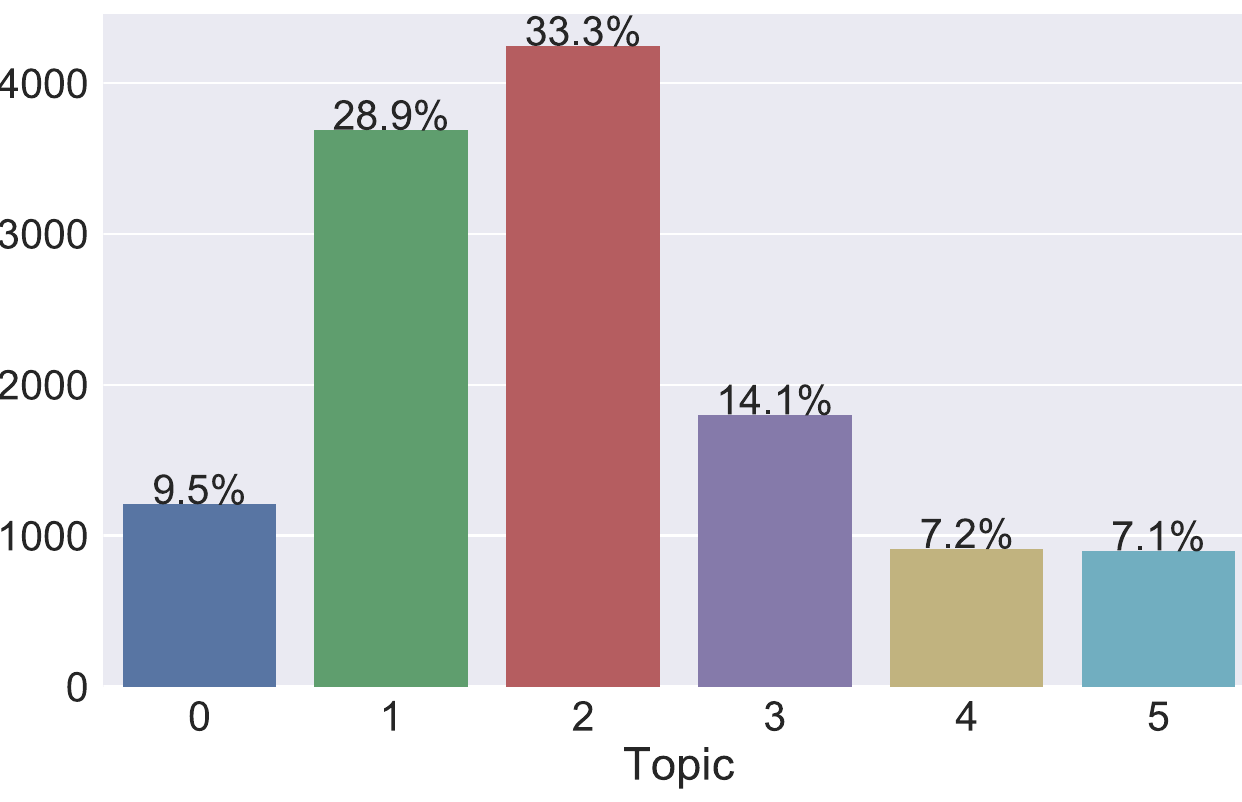
Fig 3. Topic distribution in the cohort. To visualize the prevalence of each topic in the cohort, we assigned an individual to the topic with the maximum score.